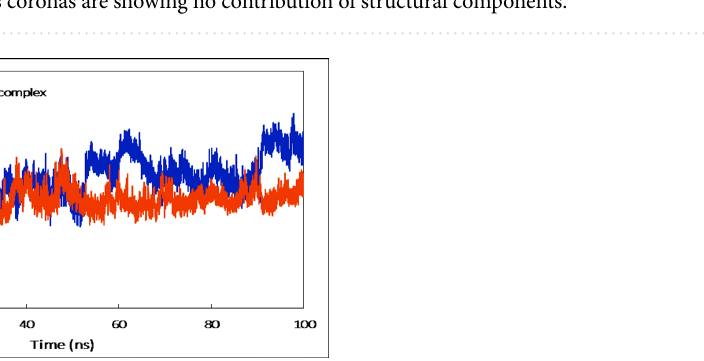
Figure 9. Root mean square deviation (RMSD) of backbone of NEK7 and NEK7-M12 complex as function of